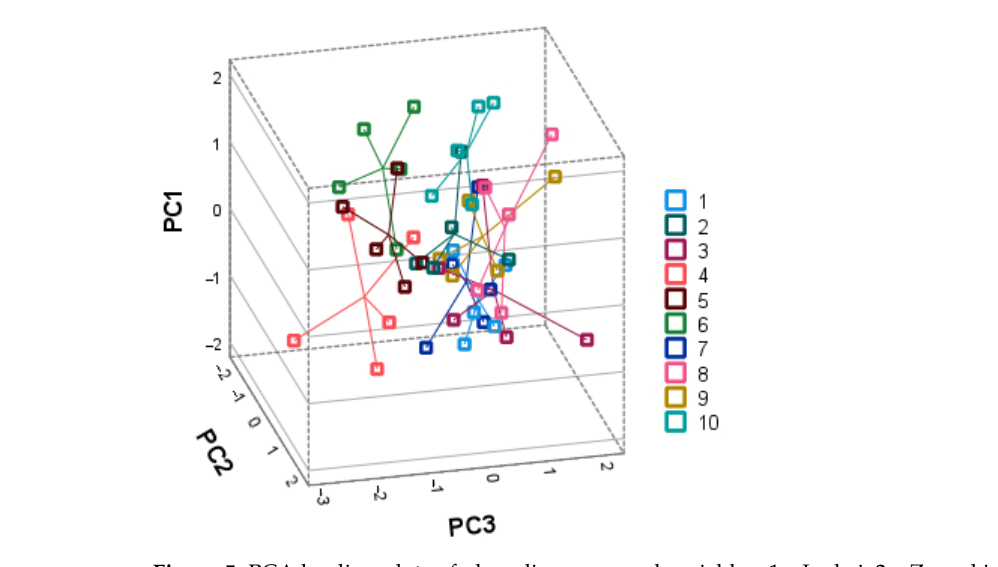
Figure 5. PCA loading plots of phenolic compound variables. 1—Jankai; 2—Zapyskis; 3—Kalnenai; 4—Sudargas; 5—Gerdziai; 6—Eiciai; 7—Bingeliai; 8—Prienai; 9—Jurasiskes; 10—Paryzines.